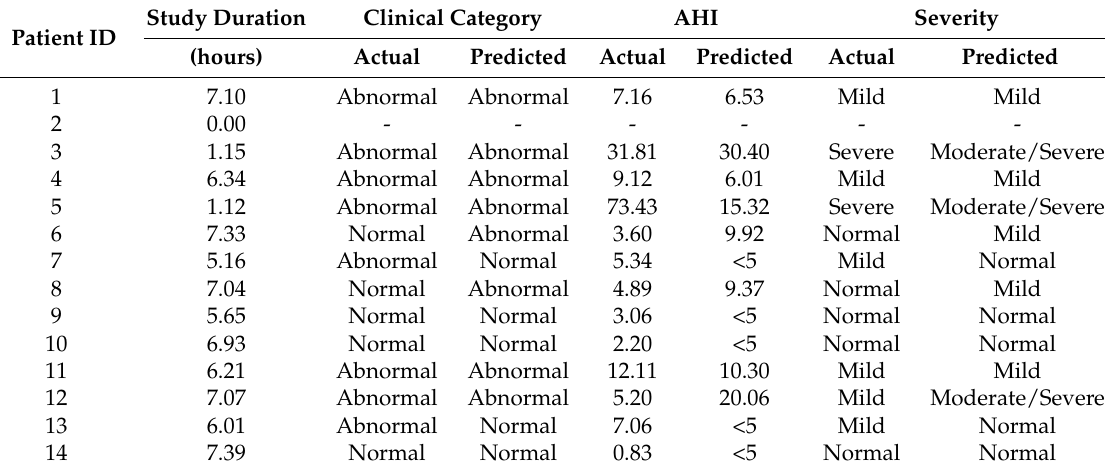
Table 2. Results of in-clinic overnight attended